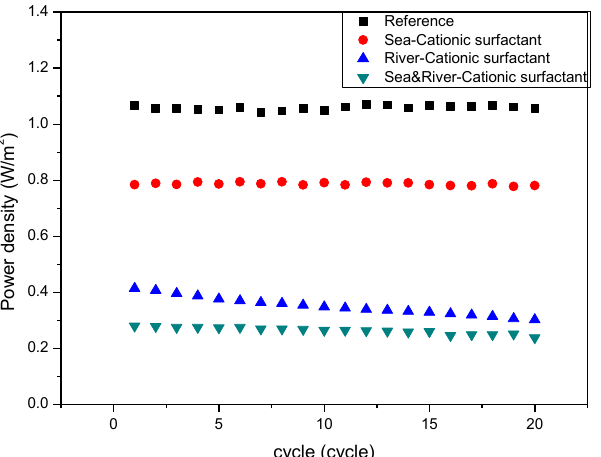
Figure 5. Variation of power density of the RED systems with the number of operation cycles with respect to the presence of the cationic foulant (CPC) included in seawater, river, or both.